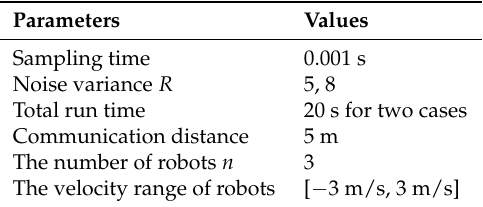
Table 1. Parameters of the simulation environment.